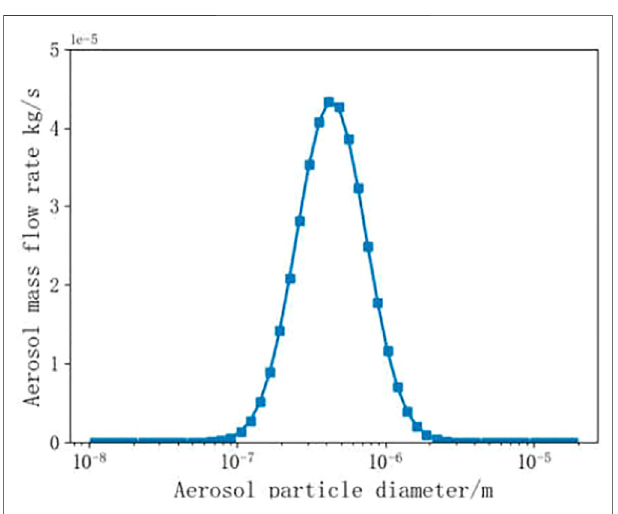
FIGURE 7 | Aerosol deposition along with the test pipe.